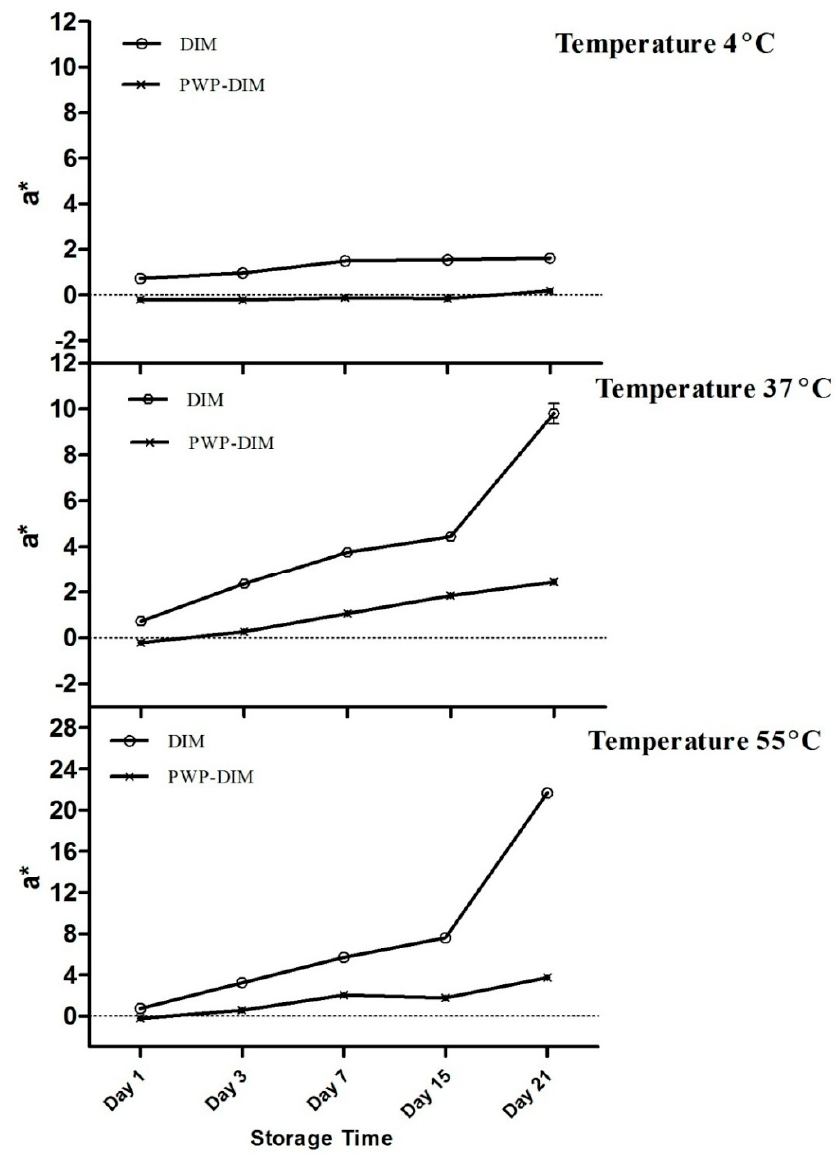
Figure 4. Effect of storage temperature (4, 37 and 55 °C) on the green-red axis (a*-value) of DIM and PWP/DIM with mass ratio (5:1) nanoparticles during storage. Values are mean ± SD ( n = 3).